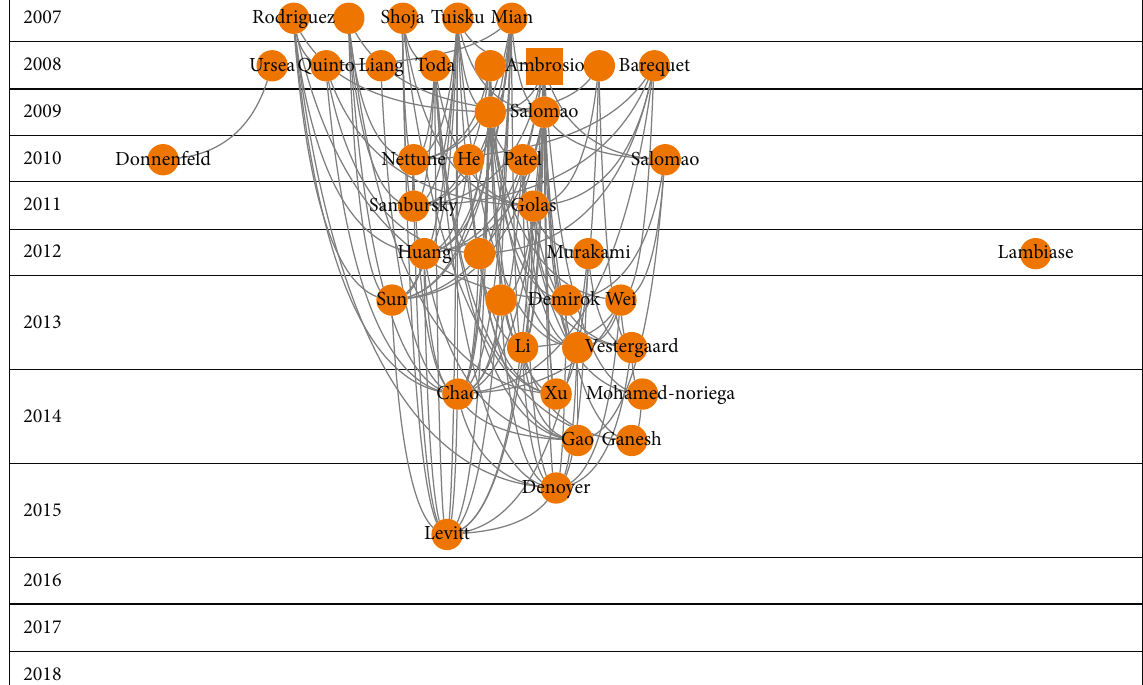
Figure 5: Citation network of cluster 4.